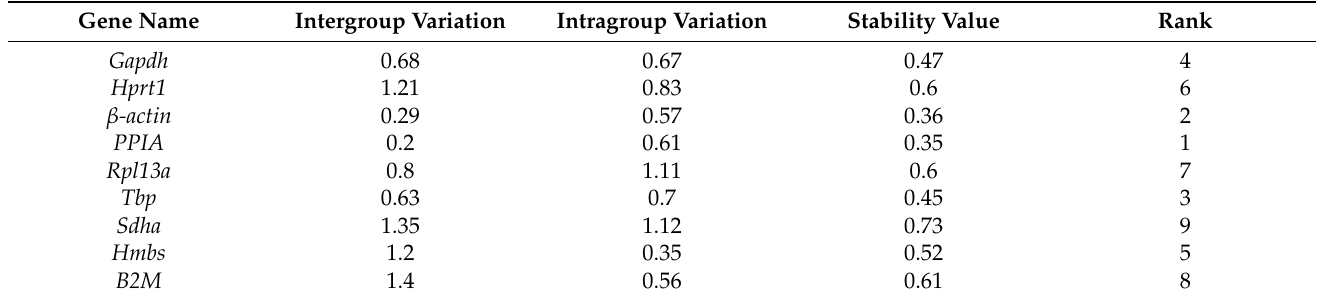
Table 10. Expression features in hypothalamus tissues at the developmental stage of PND 12w under different photoperiod conditions analyzed by